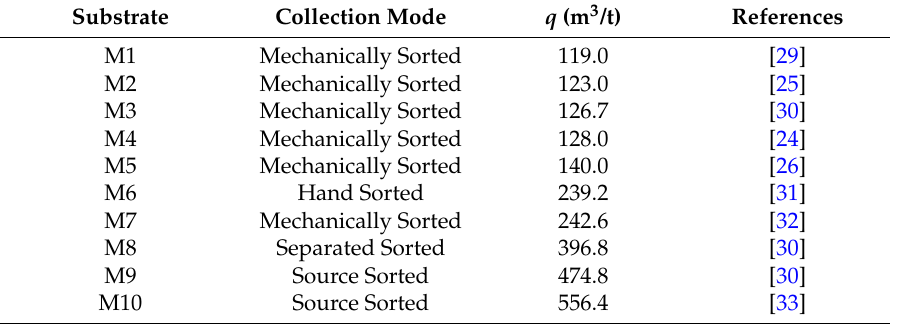
Table 4. Substrates chosen from the authors along with their biogas production per unit of mass.